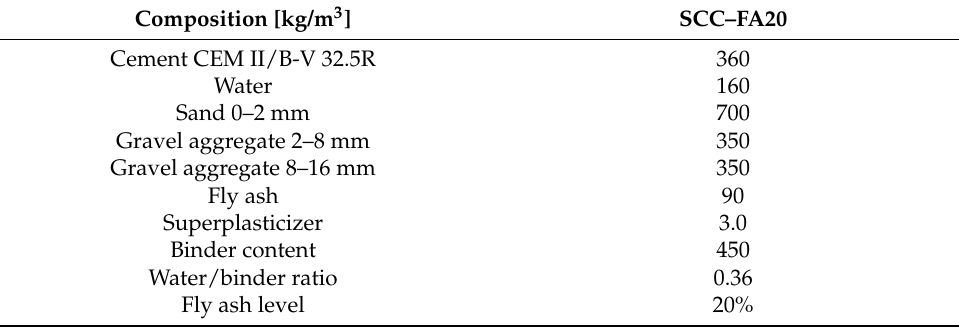
Table 1. Self-compacting concrete mix composition.